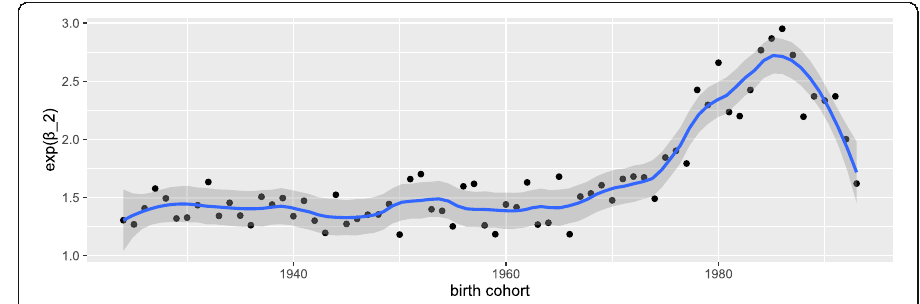
Fig. 7 Yearly variation in the effect of hukou on higher